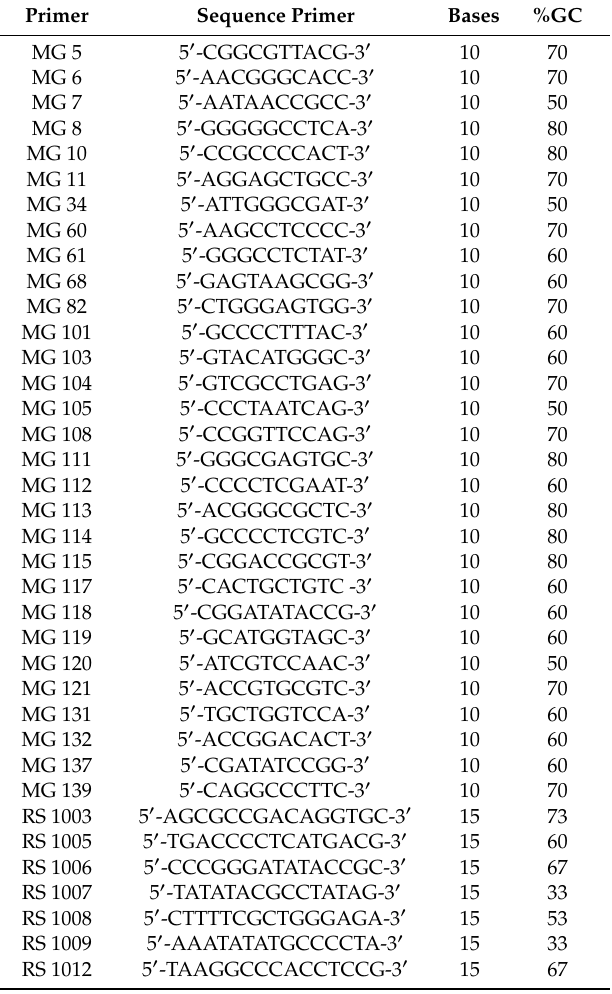
Table 1. Primers used in the